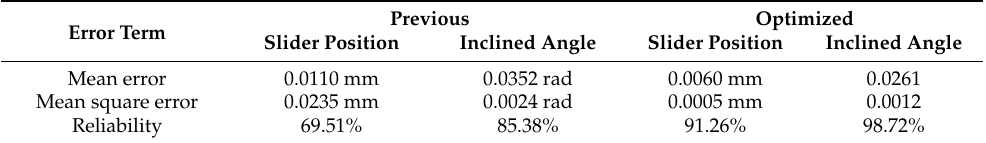
Table 5. Comparison of errors before and after